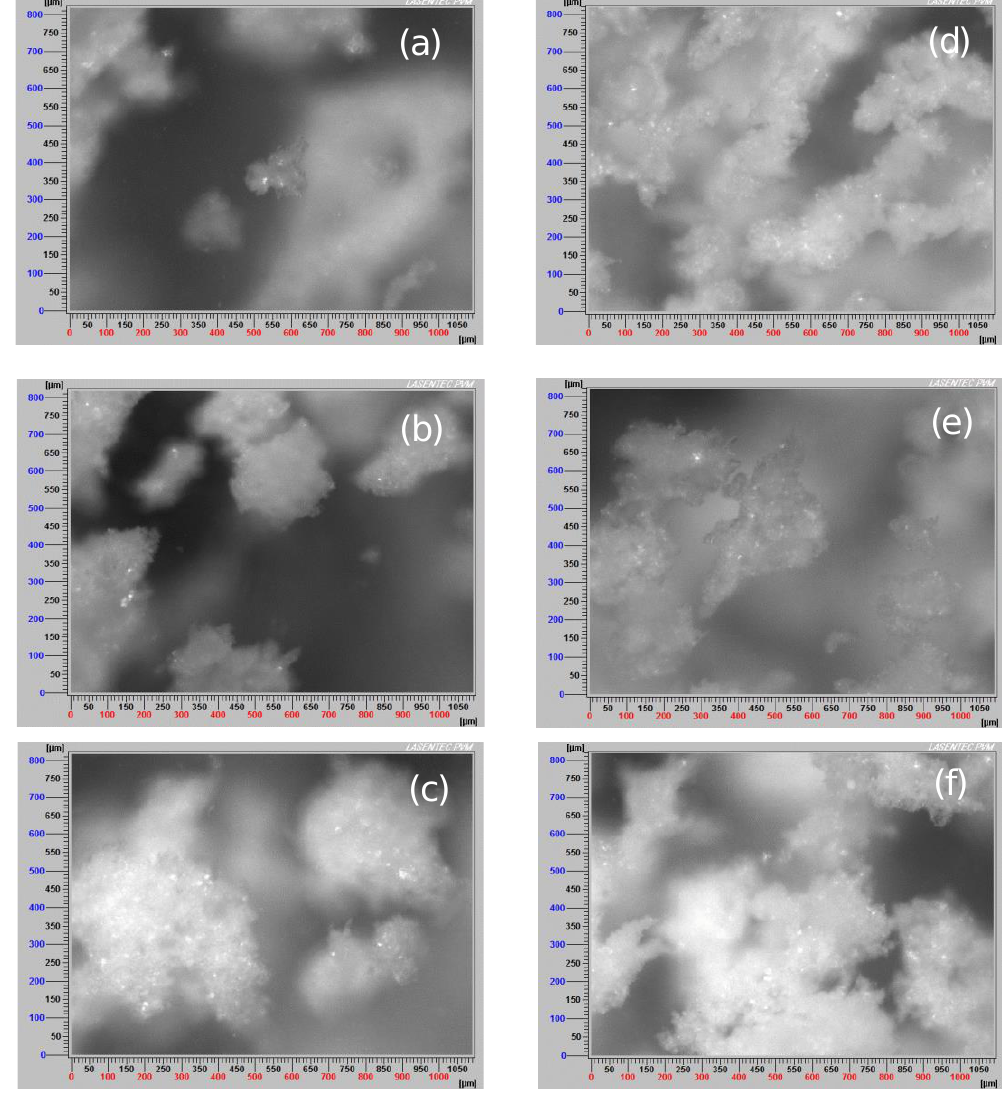
Figure 13. PVM images of flocculated kaolin suspensions with solid concentration 5 wt% and dif-